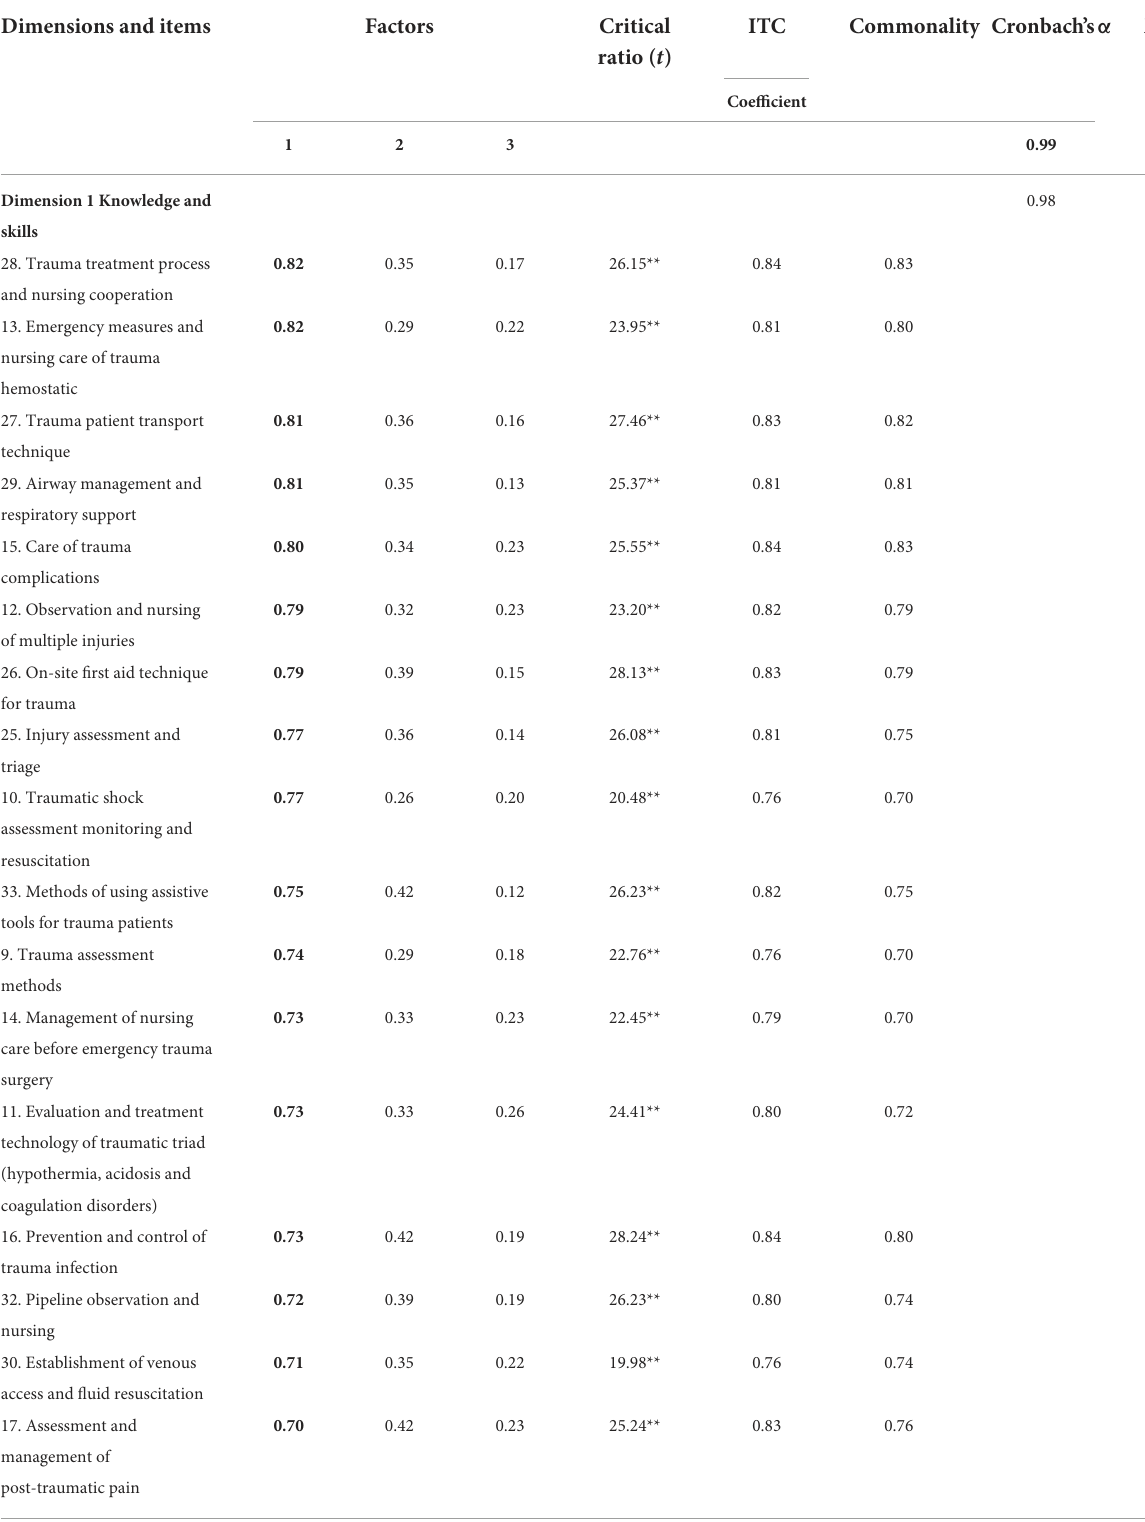
TABLE 2 Psychometric assessment and construction